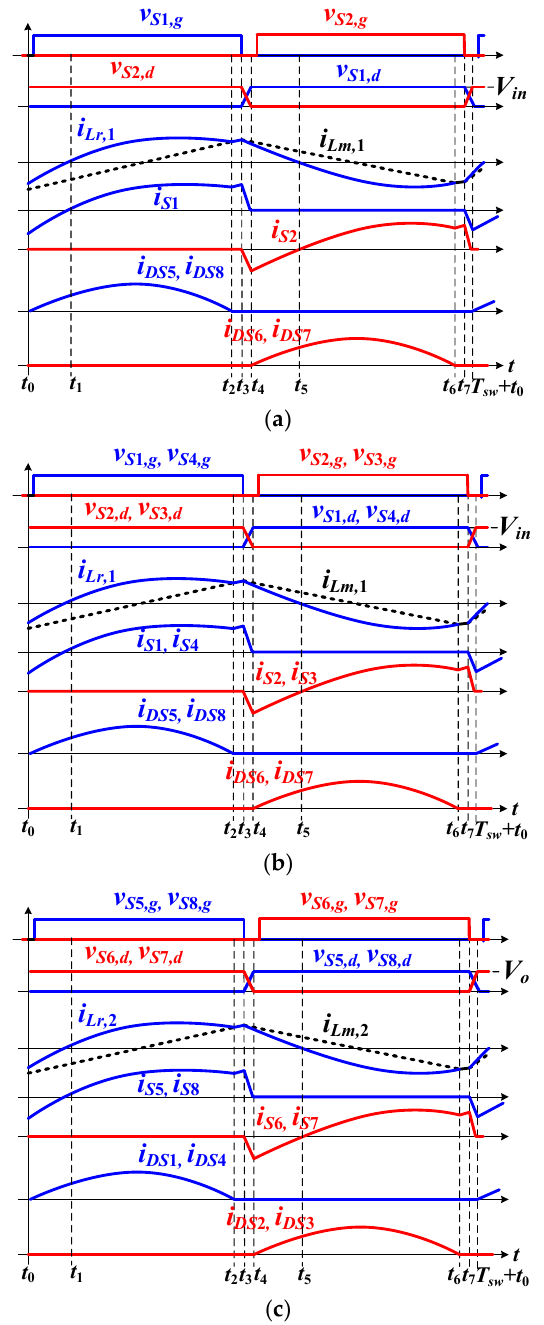
Figure 4. Main voltage and current waveforms of the proposed converter at ( a ) forward power operation and low-output voltage range; ( b ) forward power operation and high-output voltage range; ( c ) backward power operation.